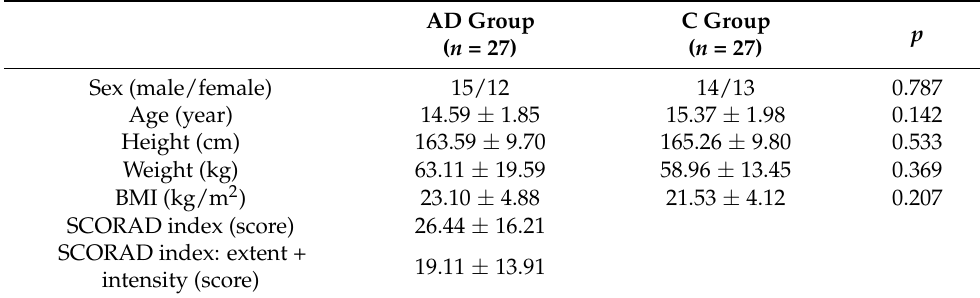
Table 1. General characteristics of the participants in each group.